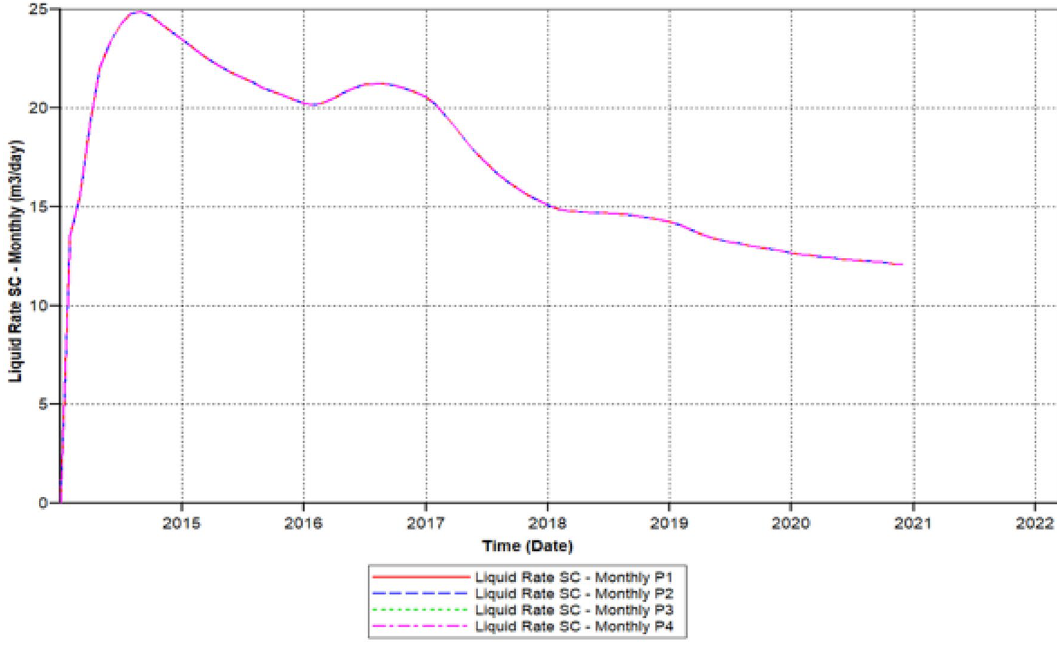
Figure 9. Shows the polymer sand plug model liquid ratio CMG STARS 2017.10 URL: https:// www. cmgl. ca/.